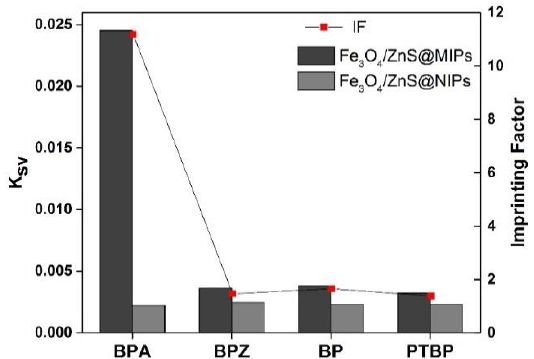
Figure 7. The quenching constant （ K sv ） and the imprinting factor （ IF ） of BPA, 1.1-Bis (4- hydroxyphenyl) cyclohexane (BPZ), 4,4’ -bisphenol (BP) and 4-tert-butylphenol (PTBP).